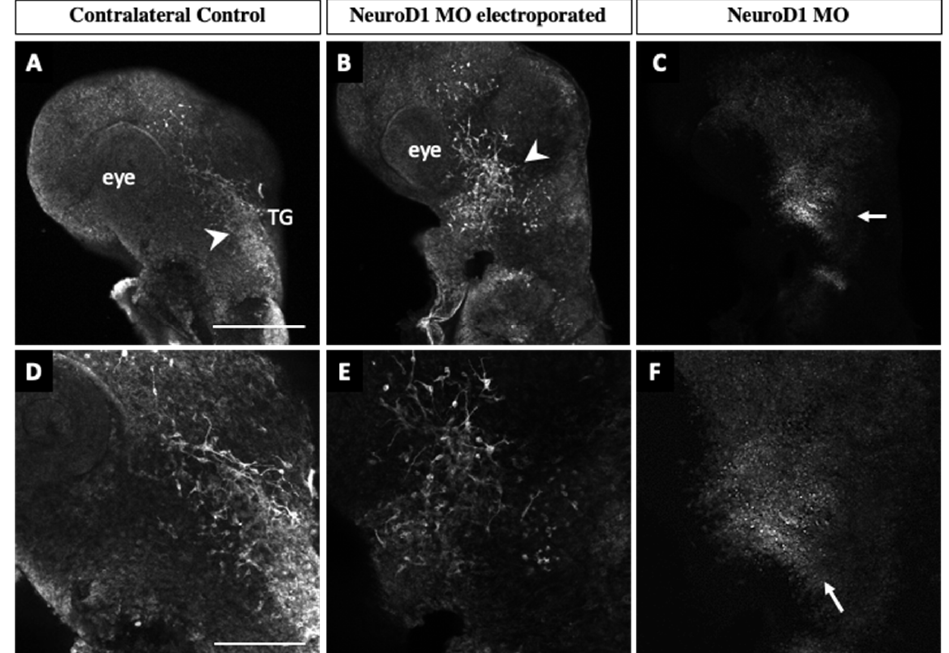
Figure 6. Depletion of NeuroD1 in trigeminal placode cells impairs trigeminal ganglion development. Lateral view of the trigeminal ganglion in a chick head (E2 (HH14), n = 3). Representative images are maximum intensity projections of confocal Z-stacks through the contralateral control ( A , D ) and NeuroD1 MO-electroporated ( B , E ) sides after processing for whole-mount Tubb3 immunohistochemistry to detect placode-derived neurons ( A , B , D , E , arrowheads) and tissue clearing. Bottom row shows higher magnification images of the top row. ( C , F ) MO-positive cells (arrows). Scale bar in ( A ) is 500 µ m and applies to ( B , C ), and 200 µ m in ( D ) and applies to ( E , F ). Abbreviations: TG, trigeminal ganglion.